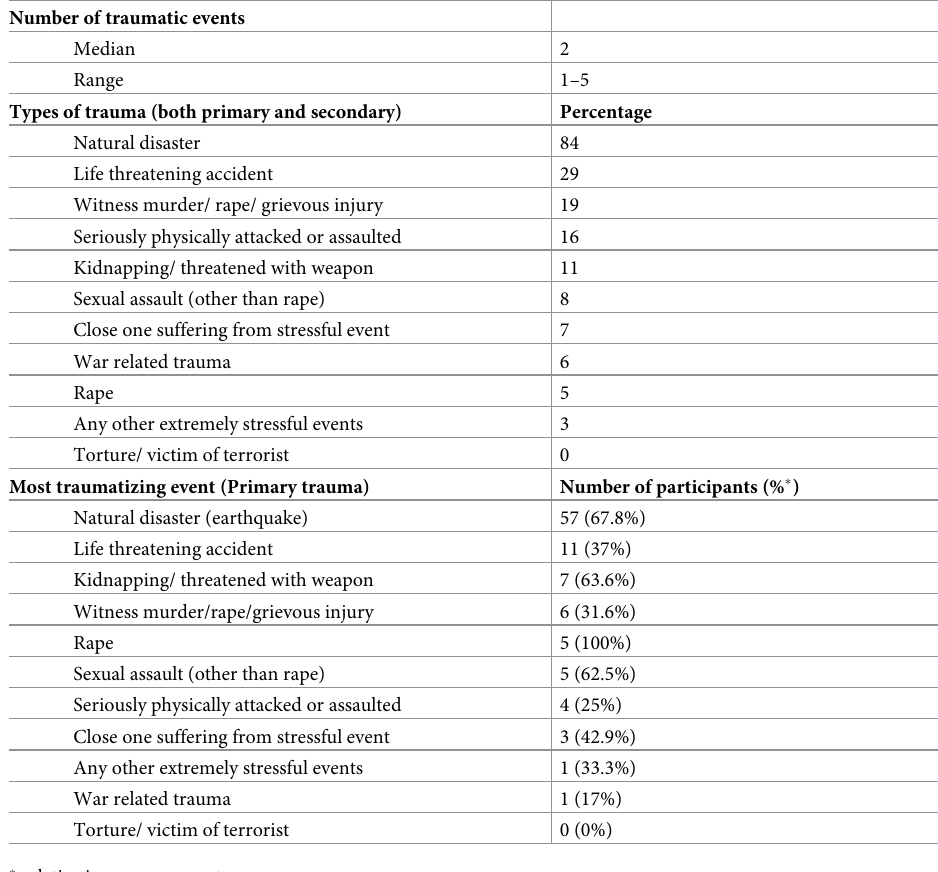
Table 2. Characteristics of